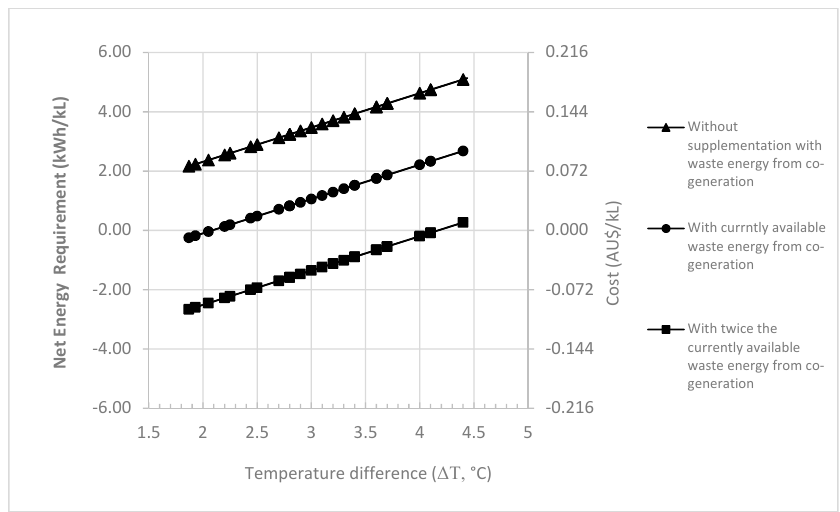
Figure 7. Energy requirement from purchased gas as a result of heat loss in treated wastewater with and without waste heat from current level of WTP co-generation (107,250 MWh/a). Cost of purchased gas requirement calculated for a gas price of AU$10/GJ [23].